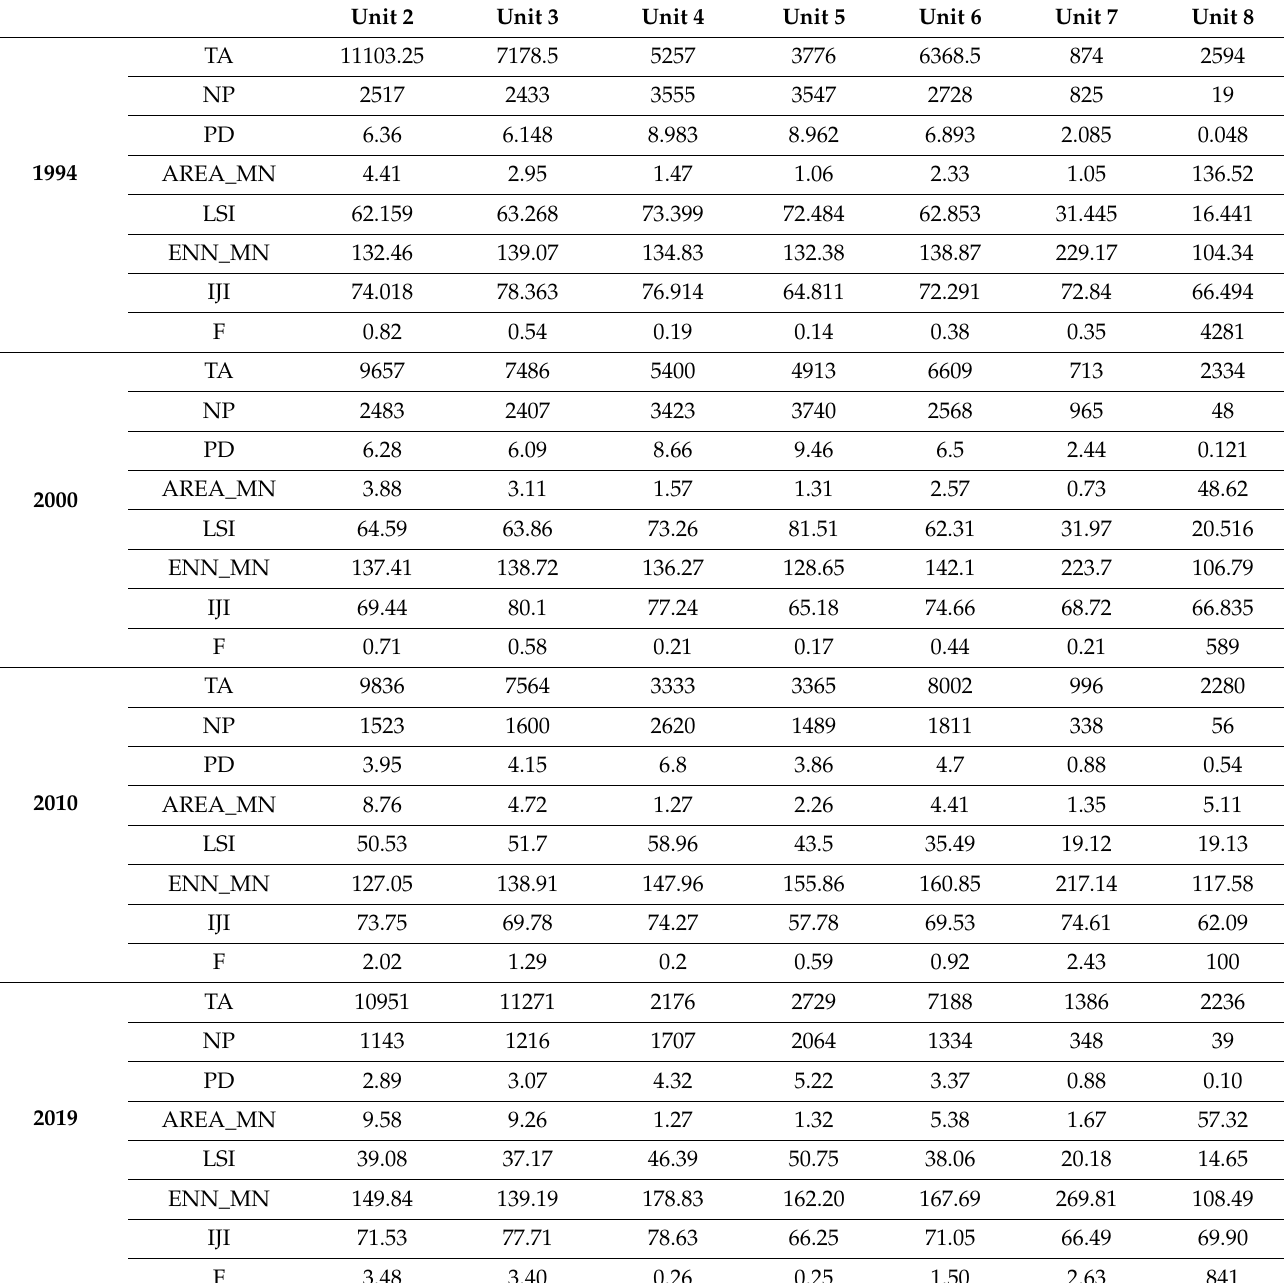
Table 7. Table of area, density, and aggregation metrics of the patches obtained by the FRAGSTAT software. Where: TA: Total area; NP: Number of Patches; PD: Patch Density; AREA_MN: Mean Patch Area; IJI: Interspersion and Juxtaposition Index; Frag: Fragmentation